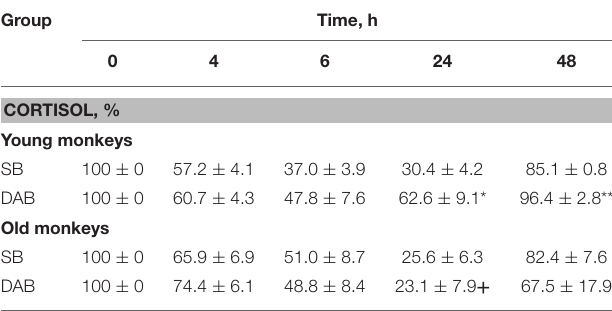
TABLE 3 | Dynamics of CORT concentration in peripheral blood plasma of young and old female rhesus monkeys with SB and DAB in response to administration of DEX as a percentage of baseline (mean ±